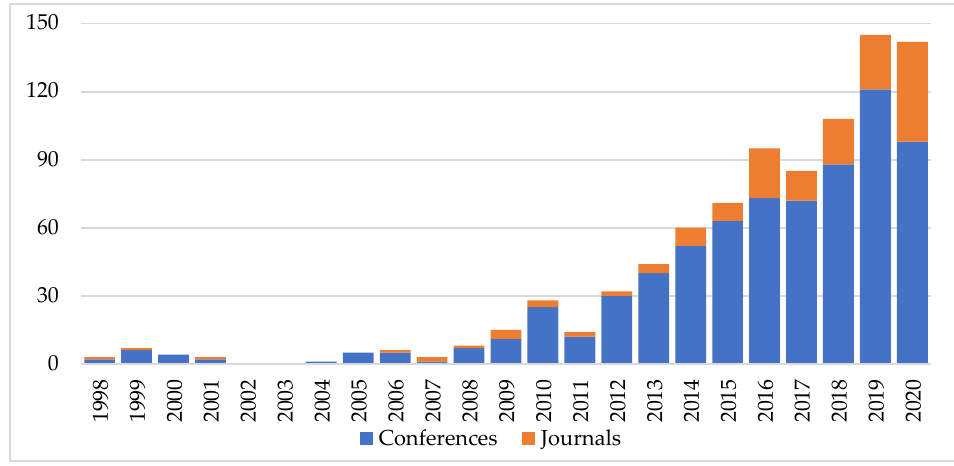
Figure 1. Number of recent IEEE publications about BESS.